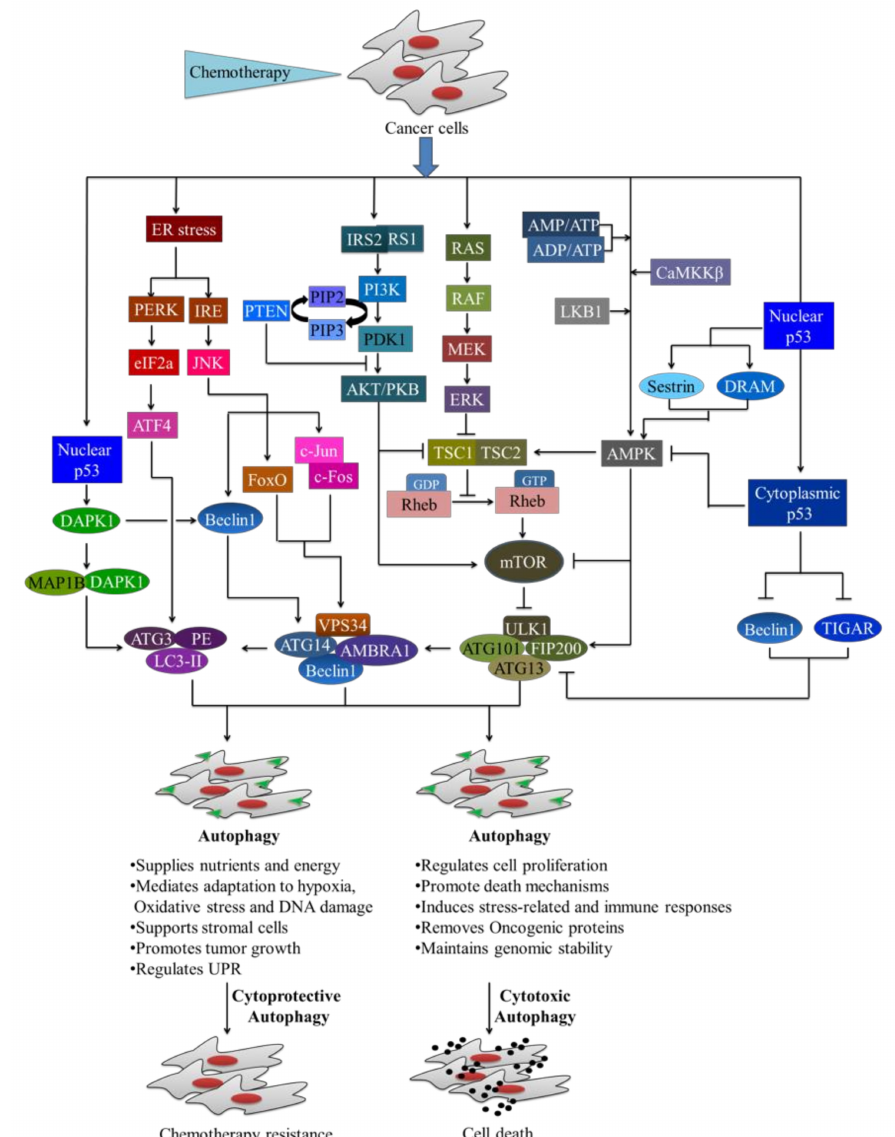
Figure 5. Possible pathways involved in autophagy-mediated cell survival or cell death. Chemother- apy can be activated cytotoxic or cytoprotective autophagy by a variety of signaling pathways; including the mTOR, phosphoinositide-dependent protein kinase B/AKT (PKB/AKT) pathway, AMP-activated protein kinase (AMPK), tumor suppressor p53 pathway, mitogen-activated protein kinase (MAPK) signaling, FOXO3A-PUMA signaling, and ER stress, etc. IRS1/2: insulin recep- tor substrate 1 and 2; PI3K; phosphatidylinositol 3-kinase; PDK1: phosphoinositide-dependent protein kinase 1; PTEN: phosphatase and tensin; PIP2: phosphatidylinositol-4,5-bisphosphate; PIP3: phosphatidylinositol-3,4,5-trisphosphate; PKB: phosphoinositide-dependent protein kinase B; RAS: rat sarcoma; RAF: rapidly accelerated fibrosarcoma; ERK: extracellular signal regulated kinases; MEK: mitogen-activated protein kinase/ERK kinase; TSC1/2: tuberous sclerosis complex 1 and 2; GDP: guanosine diphosphate; GT: guanosine triphosphate; mTOR: mammalian target of rapamycin; LC3-I/II: light chain 3 I and II; PERK: protein kinase R (PKR)-like endoplasmic reticulum kinase (PERK); eIF2: eukaryotic initiation factor 2; DAPK1: death-associated protein kinase 1; DRAM: damage regulated autophagy modulator; TIGAR: TP53-induced glycolysis and apoptosis regulator; LKB1: liver kinase B1; CaMKK: calcium/calmodulin-dependent protein kinase kinase; Rheb: ras homolog enriched in the brain; AMPK: AMP-activated protein kinase; ATG: autophagy